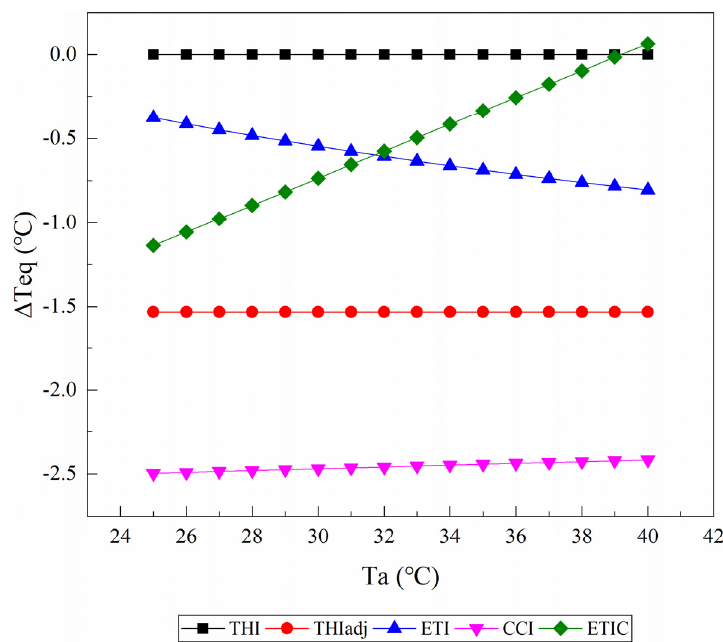
Figure 4. The changes of the equivalent ambient temperature change ( Δ Teq) caused by an increase in wind speed from 1 m/s to 2 m/s as air temperature (Ta) rises from 25 to 40 °C are reported from the temperature–humidity index (THI), adjusted THI (THIadj), equivalent temperature index (ETI), comprehensive climate index (CCI), and equivalent temperature index for dairy cattle (ETIC). Relative humidity is assumed to be 50%, and solar radiation is assumed to be 0 W/m 2 . THI2, THI3, and black globe humidity index (BGHI) are not included since they do not contain wind speed and relative humidity.